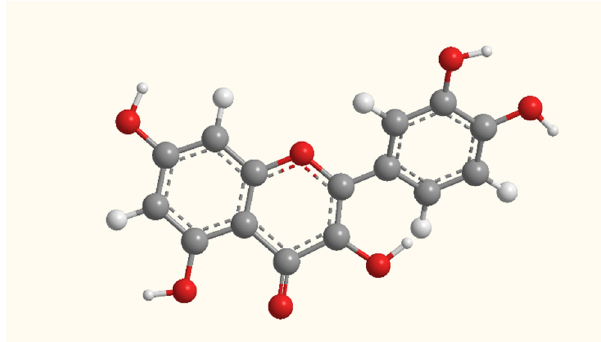
Figure 1. Quercetin’s chemical structure (molecular formula: C 15 H 10 O 7 ).